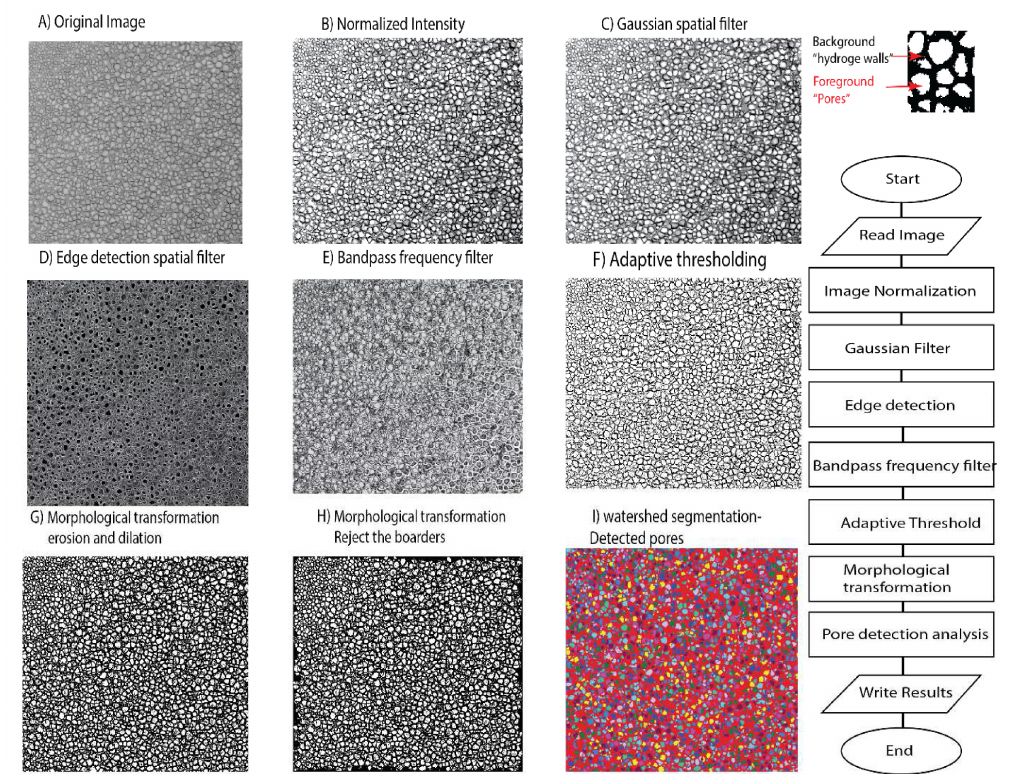
Figure 1. Image processing algorithm of sample cryo-SEM micrograph of glycidyl methacrylate hydrogel crosslinked with 0.3 mol% (ethylene glycol) dimethacrylate. Images on the left show the output images of each step in the processing algorithm and the relevant flowchart is illustrated on the right to distinguish foreground (pores) from background (hydrogel walls). The source image adapted from Kaberova et al. 8 with